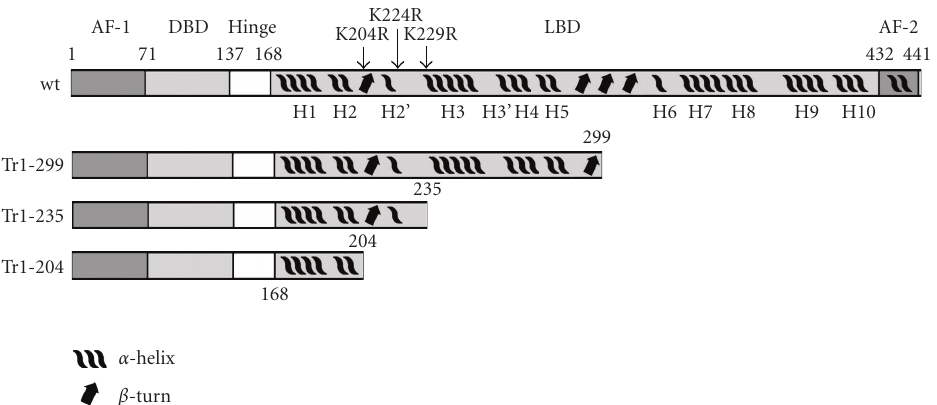
Figure 1: Domain structure of PPAR δ and truncated forms of the receptor. AF-1, N-terminal ligand-independent activation function 1 (aa 1–70). DBD, DNA binding domain (aa 71–136). Hinge, flexible hinge region (aa 137–167). LBD, ligand-binding domain (aa 168–431). AF-2, C-terminal ligand-dependent activation function-2 (aa 432–441). The position of the mutations (K204R, K224R, and K229R) introduced in the region 204–235 is